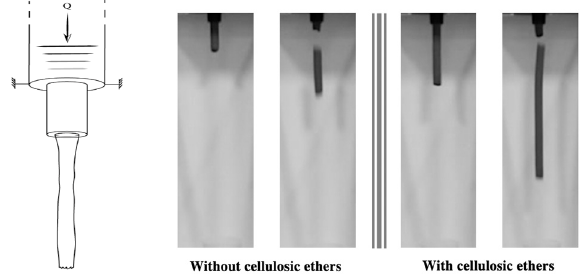
Figure 4. Schematic view of the self ‐ traction tests on extrudate samples and pictures captured during the